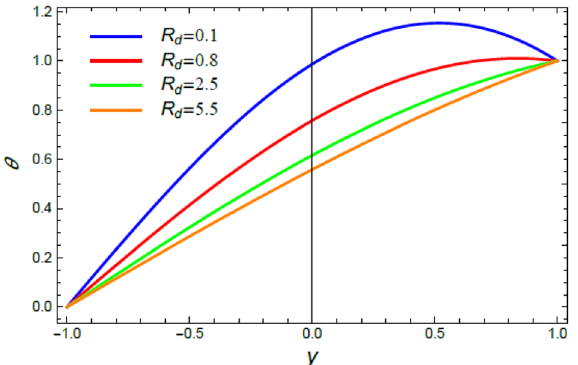
Figure 9. The impact of the radiation coefficient R d on the heat distribution θ .